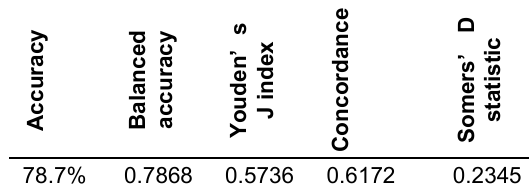
Table 4. Evaluation metrics of decision tree